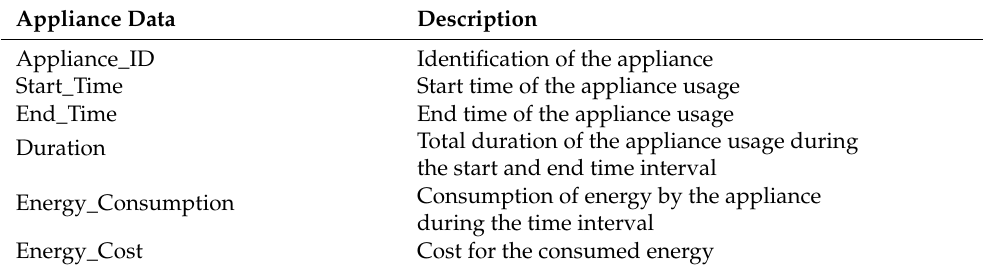
Table 3. Feature information for appliances used.